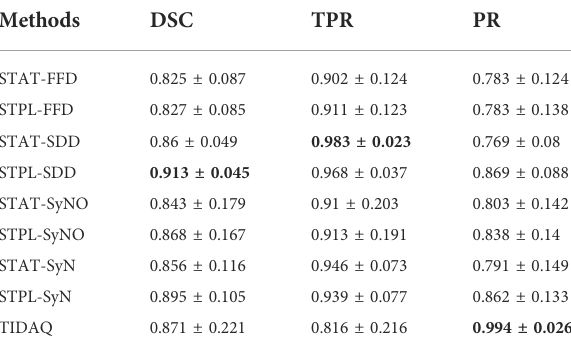
TABLE 9 66% Trabecular Bone Segmentation Performance (mean ± standard deviation). DSC: Dice Similarity Coef fi cient, TPR: True Positive Rate, PR: